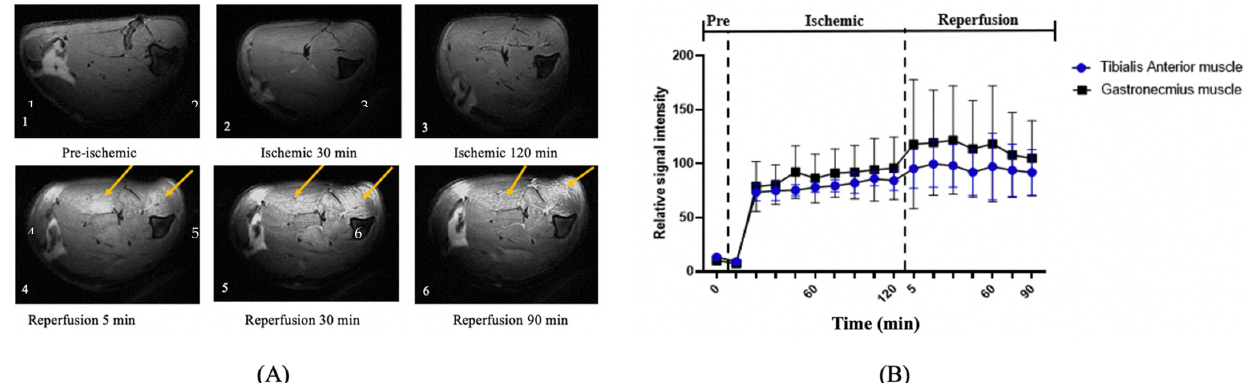
Figure 6. The change of relative signal intensity of T2-weighted images during ischemic and reperfusion states. ( A ) T2- weighted images during the experiment. Images at (1) pre-ischemia, (2) 60 min of ischemia, (3) 120 min of ischemia, and (4) 5 min, (5) 60 min, and (6) 90 min of reperfusion. Hyperintensity was seen at the beginning of the reperfusion phase. ( B ) The mean signal intensity in T2-weighted images. The mean signal intensities were calculated at two regions during the experiment (GA and TA muscles). The increasing relative signal intensity of T2-weighted images showed that the water content increased in the extracellular space. It demonstrated that the edema phenomenon gradually appeared in the reper- fusion phase.